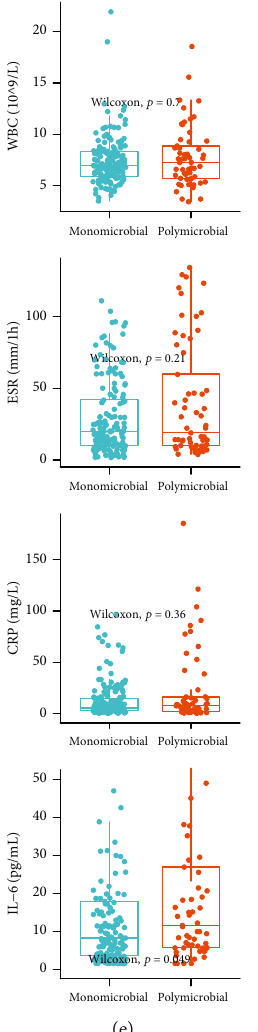
Figure 3: Plots of the in fl ammatory biomarkers in FRI patients categorized by possible in fl uencing factors. (a) Gender: female vs. male. (b) Onset of age: > 40 vs. ≤ 40 years. (c) Infection site number: single vs. multiple. (d) Tissue culture outcome: negative vs. positive. (e) Pathogen number: monomicrobial vs.